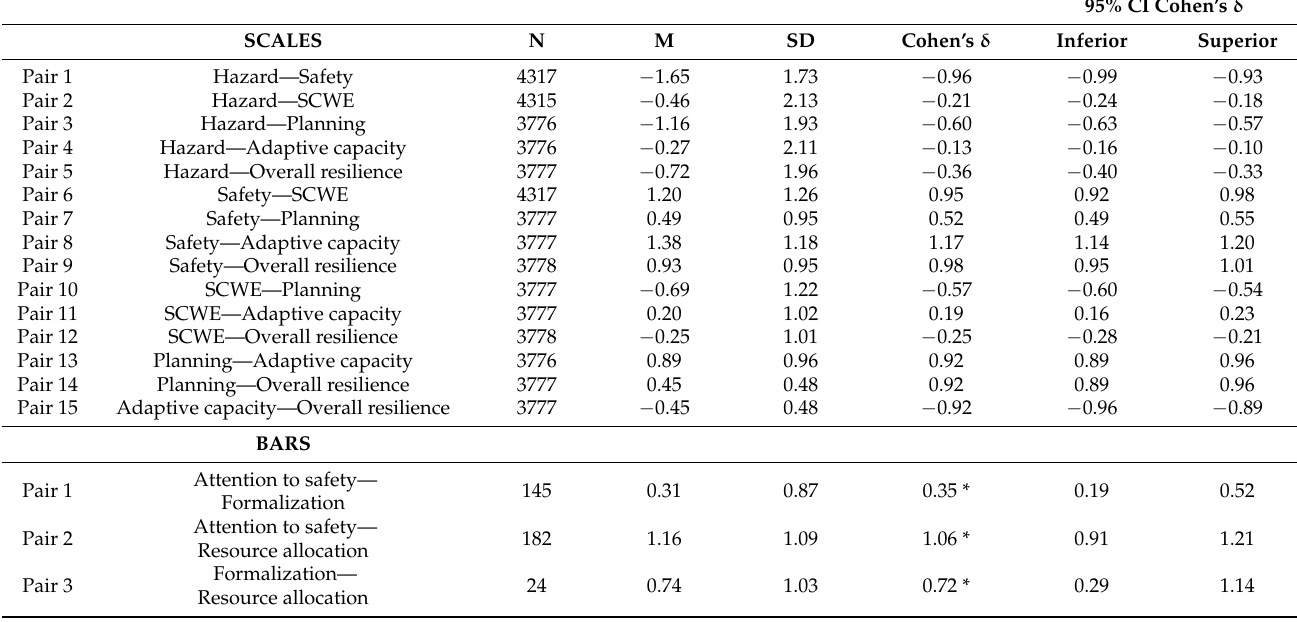
Table 5. Within-subjects comparisons for scales and BARS.